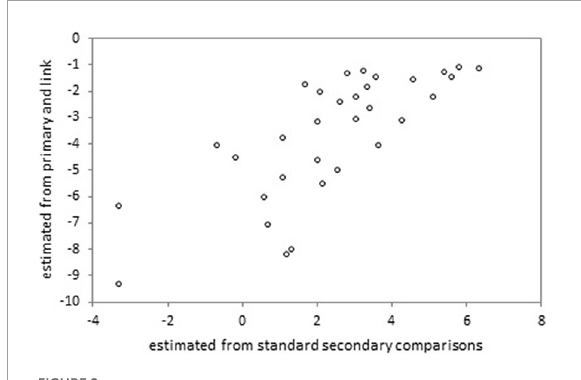
FIGURE2 Location estimates of the 32 non-core secondary performances, from two independent analyses in the scale extension